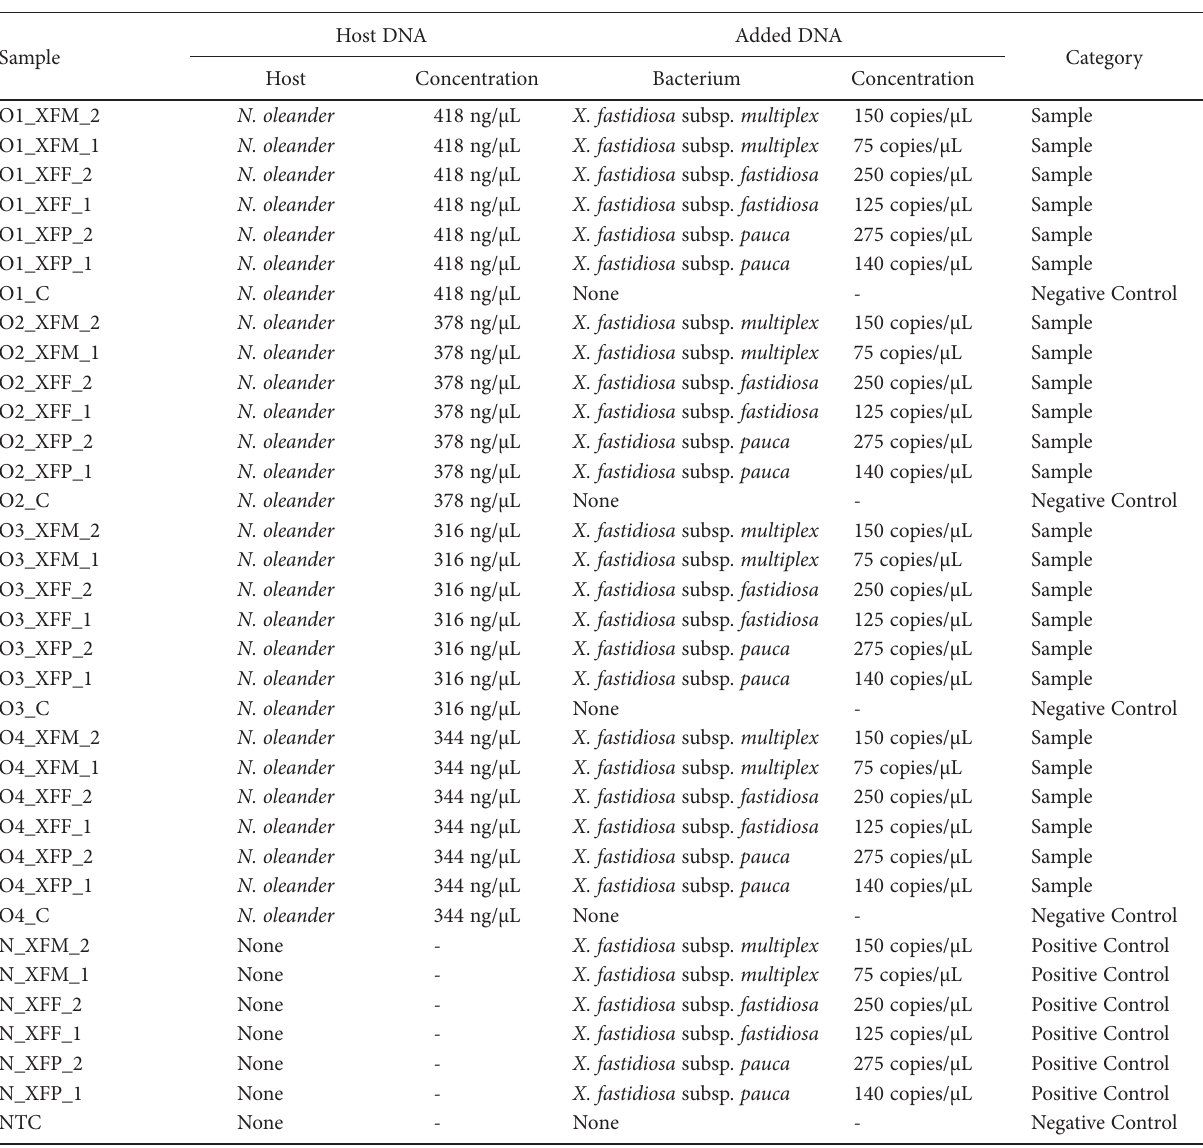
Table 2. List of samples, positive controls, and negative controls included in the second set of analyzed material. The table reports for each sample/control the name, composition of host DNA and the source of added DNA. The concentration of the nucleic acids is expressed as copy number per µL